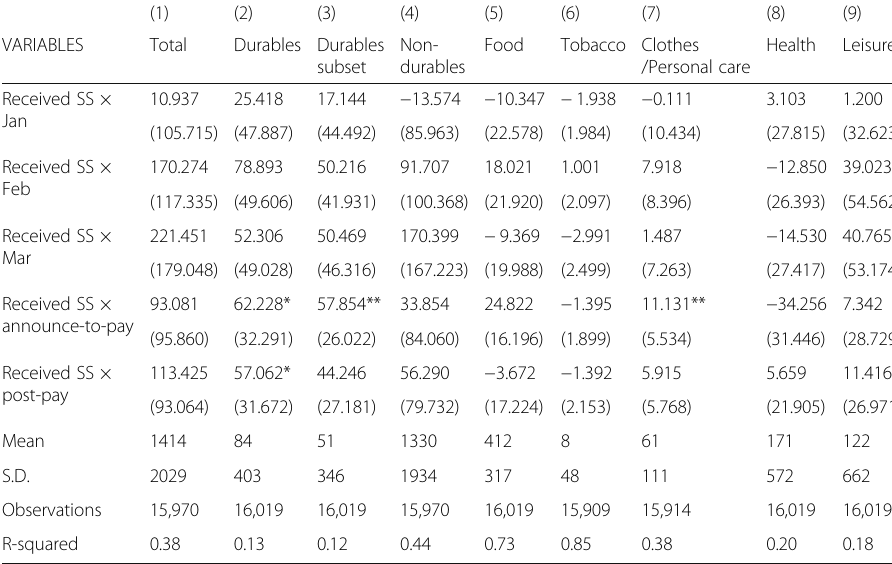
Table 21 Overall impact of receiving SSS payouts on